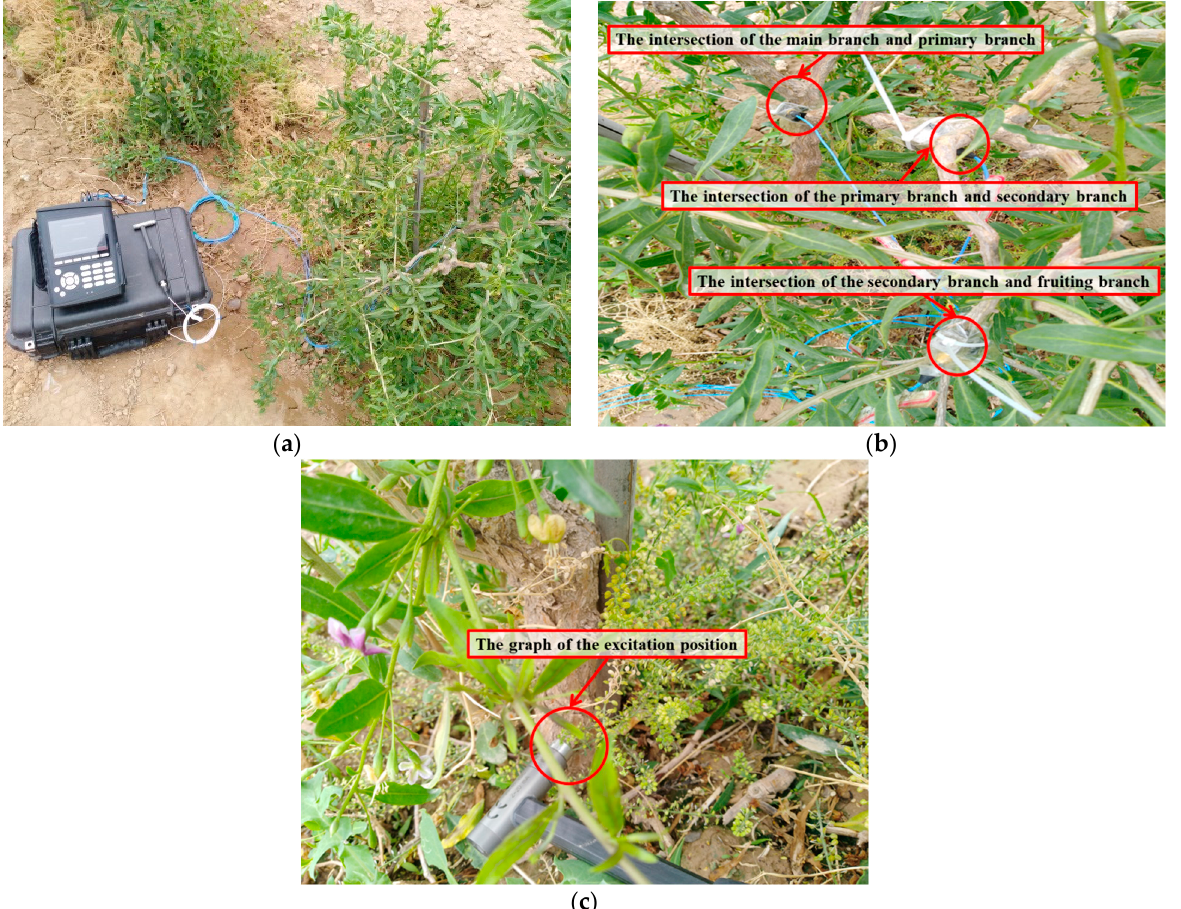
Figure 5. The modal experiment. ( a ) The global graph of the modal experiment; ( b ) the distribution of the acceleration sensors; ( c ) the graph of the excitation position.